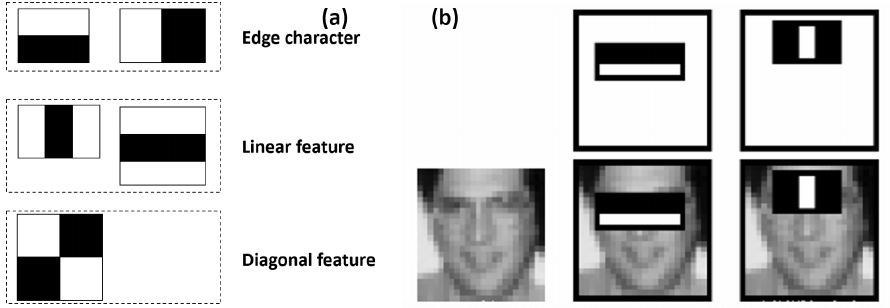
Figure 5. Haar features for object identification. ( a ) Typical Haar-like features. ( b ) Denoting a face utilizing the Haar-like